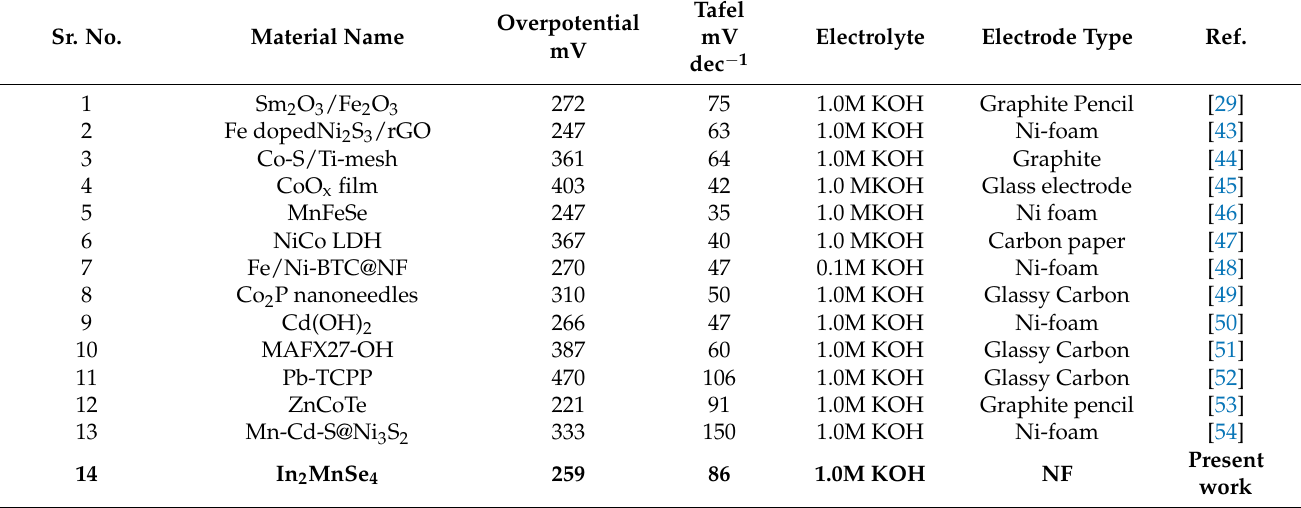
Table 1. Comparison of various OER parameters of the present material with already reported materials. Sr.